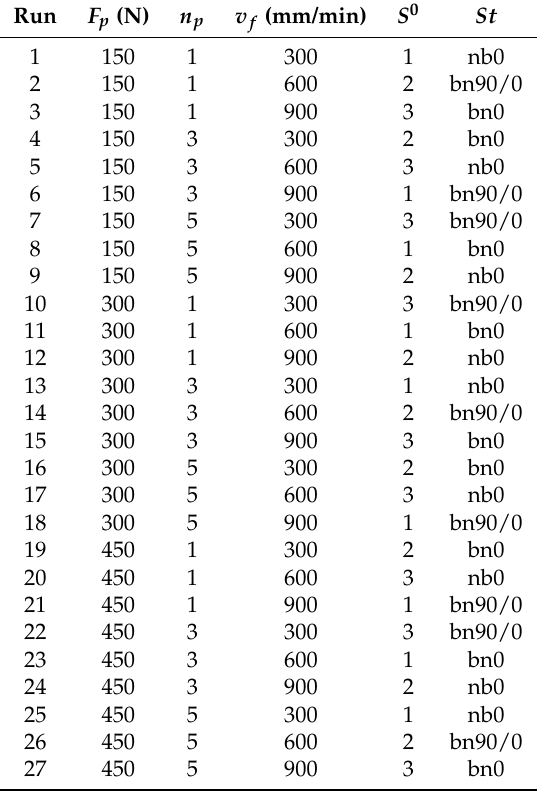
Table A1. L27 orthogonal array called for the design of the